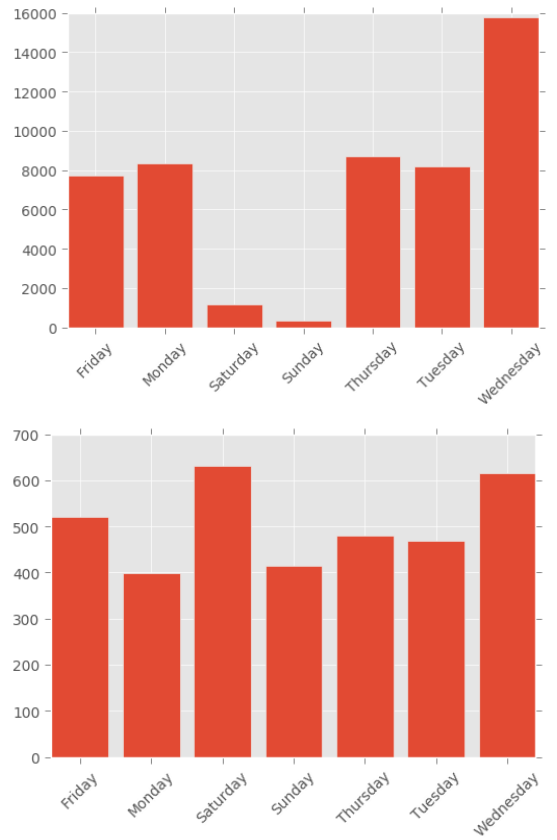
Figure 5. Number of travels in each week day based on survey data (top) and geo-tweets (bottom) In Figure 6 the first dissimilarity between two patterns is between midnight and 4 AM. The number of travels created by tweets are more than this number in survey data in this period. The peak value in survey data occurred around 16-17 o’clock, however this value occurred around 13 o’clock in the tweets Figure 4. Location of cleaned geo-tweets (top) and kernel which is again similar to the previous studies (Luo et al., density estimation (bottom)